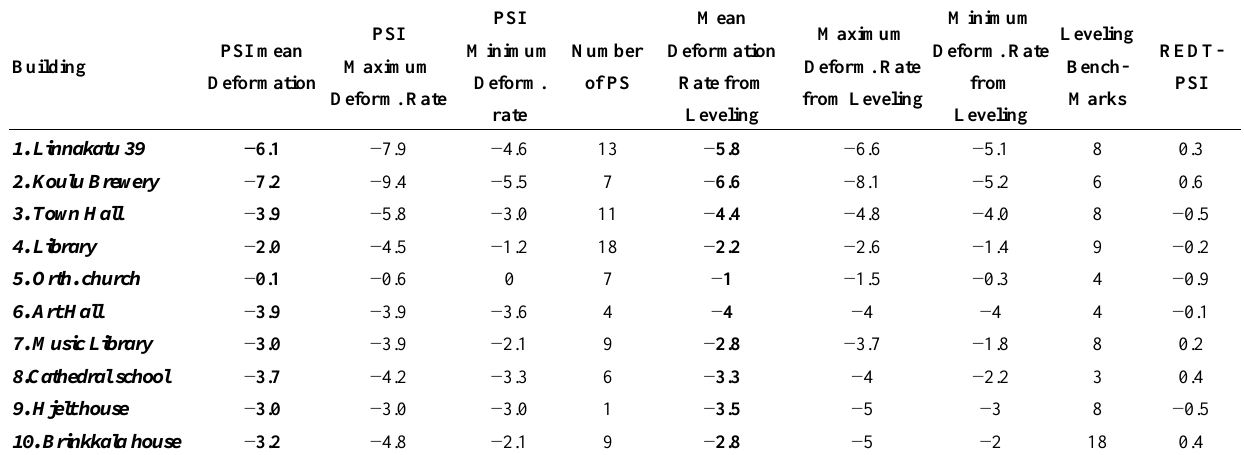
Table 5. The vertical motion rates per year for 10 different buildings from the PSI processing and the REDT leveling measurements. Mean deformation rate from PSI is on average 0.03 mm/yr slower than the mean rate from leveling. The locations of the buildings can be found in Figure 3.